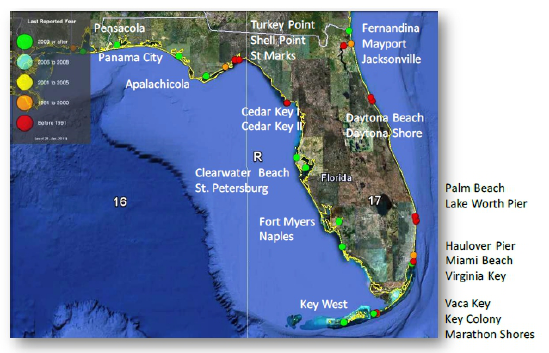
Figure 1. Distribution of 26 tide gauge stations in Florida State (PSMSL data catalogue on Google Earth